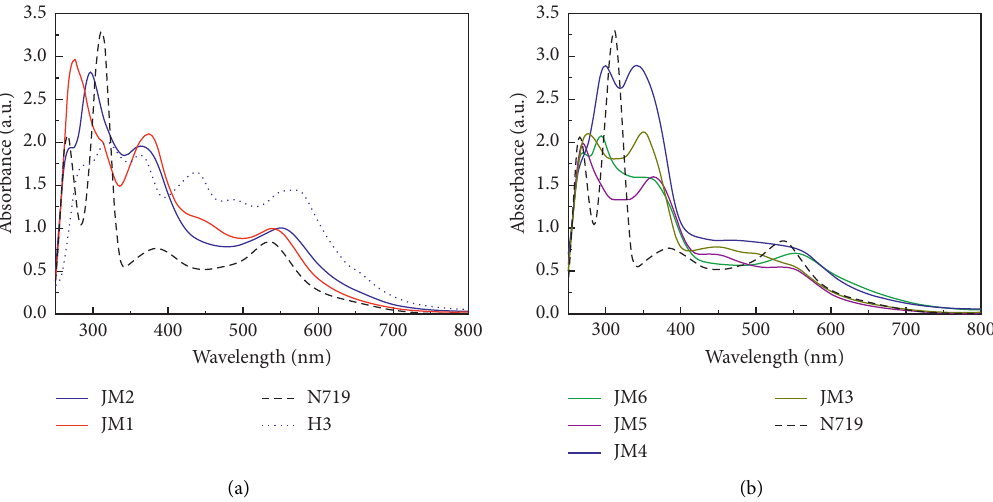
Figure 2: UV-vis absorption spectra of (a) JM1 - JM2 including N719 and H3 and (b) JM3 – JM6 including N719 measured at 298K under ambient conditions (solvent: